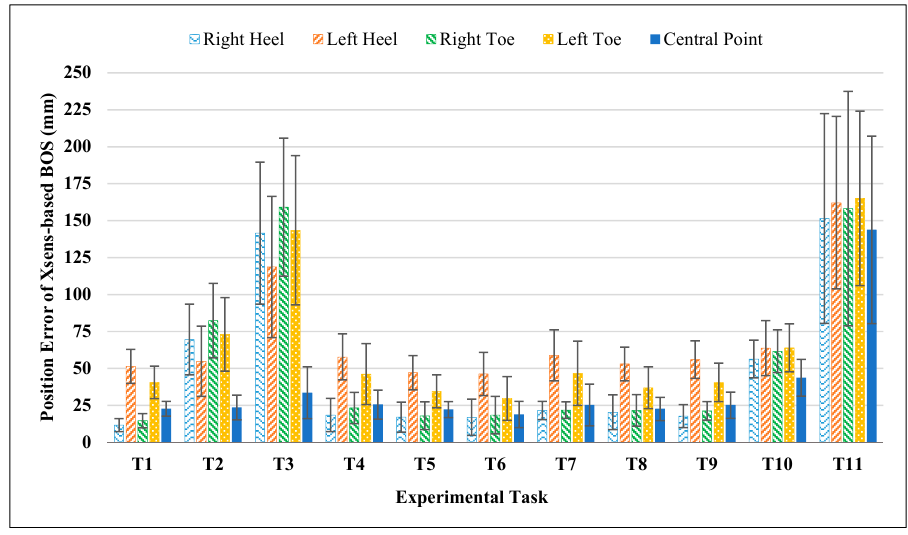
Figure 7. Position errors of Xsens-based BOS in different experimental tasks.